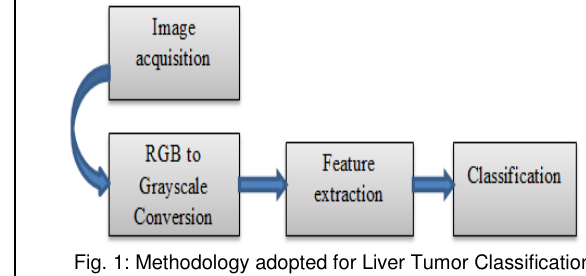
Fig. 1: Methodology adopted for Liver Tumor